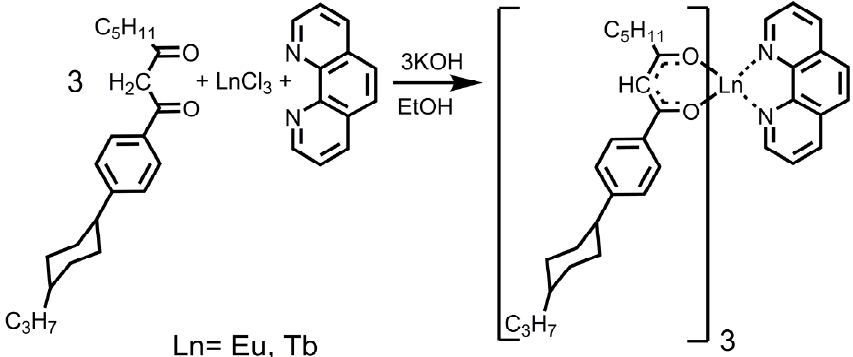
Figure 1. Synthesis of Ln(III)